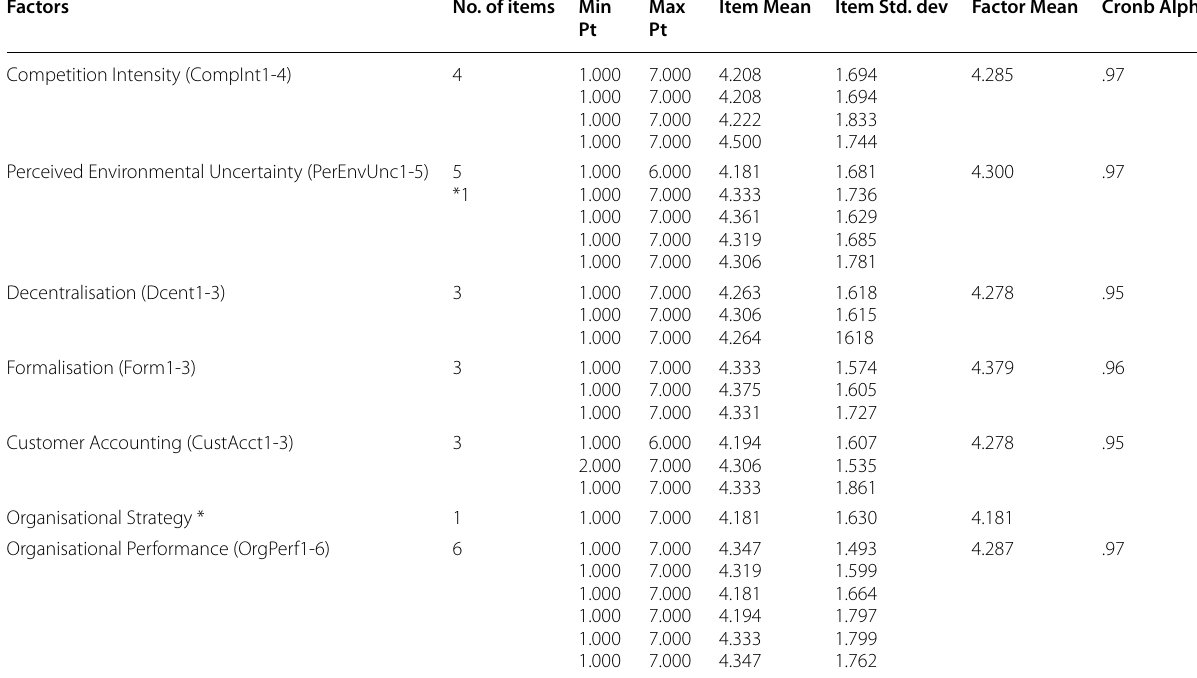
*One item was used to measure ability to compete/performance; therefore, Cronbachs alpha cannot be estimated. *1